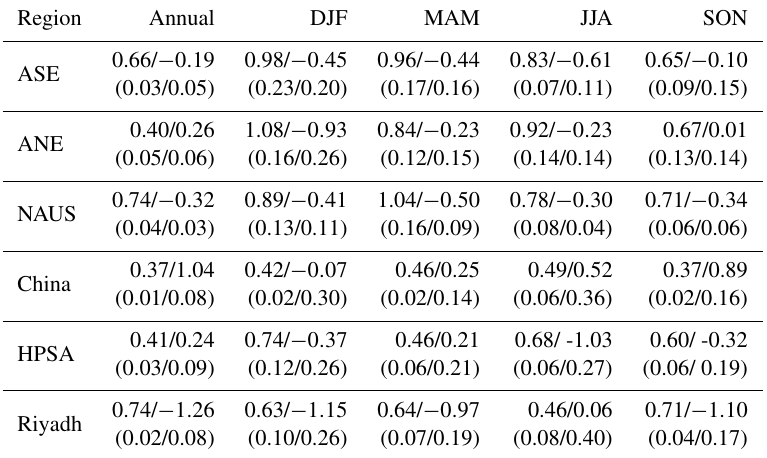
Table 5. Slope and intercept between UV NO 2 SCDs and vis blue NO 2 SCDs for the six selected regions. Intercept in 1e15moleccm − 2 . In the brackets the standard errors for both values are